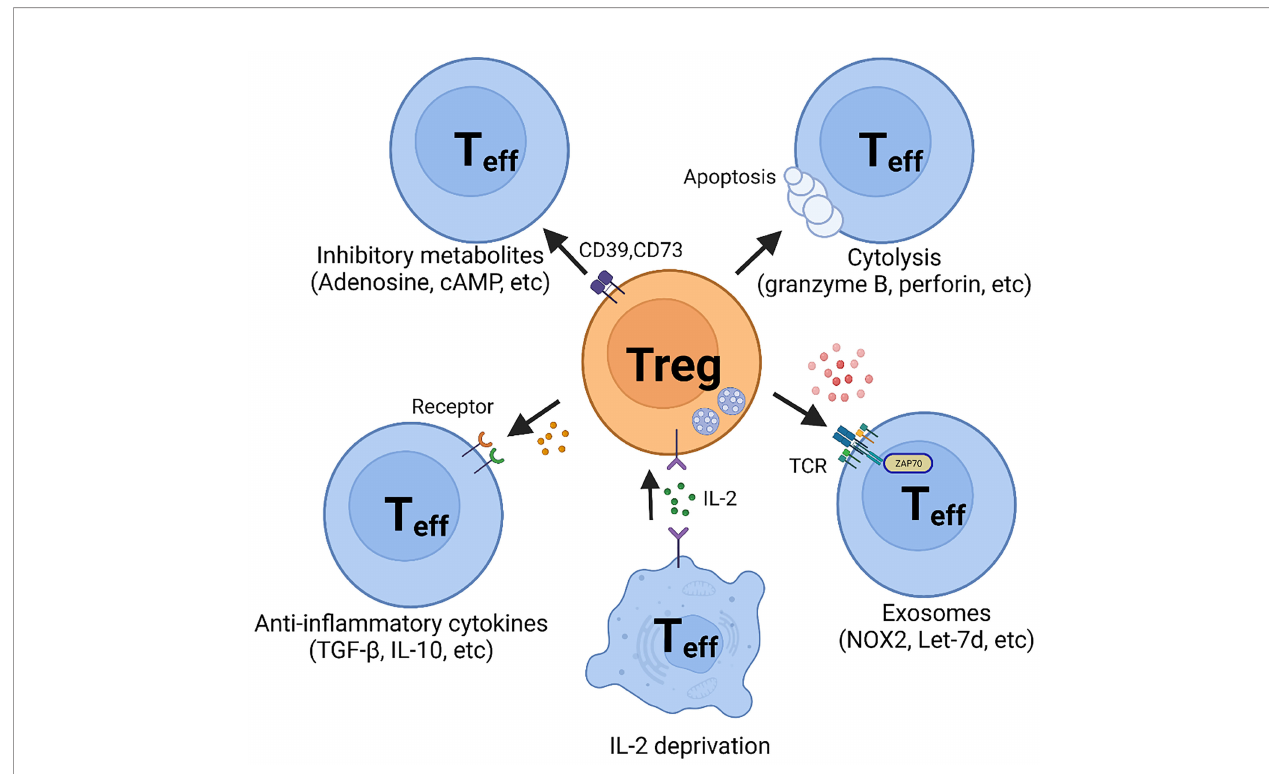
FIGURE 1 | Suppressive Mechanisms of regulatory T (Treg) cells. Regulatory T cells perform suppressive function mainly through fi ve basic mechanisms: 1. Inhibitory cytokines, such as TGF- b and IL-10; 2. Metabolic disruption, including CD39- and CD73-generated adenosine and gap junction-mediated cAMP delivery; 3. Cytolysis, utilizing granzyme B- and perforin- dependent mechanisms; 4. Exosomal delivery of immunosuppressive biomolecules, such as NOX2 and Let-7; 5. Competition for